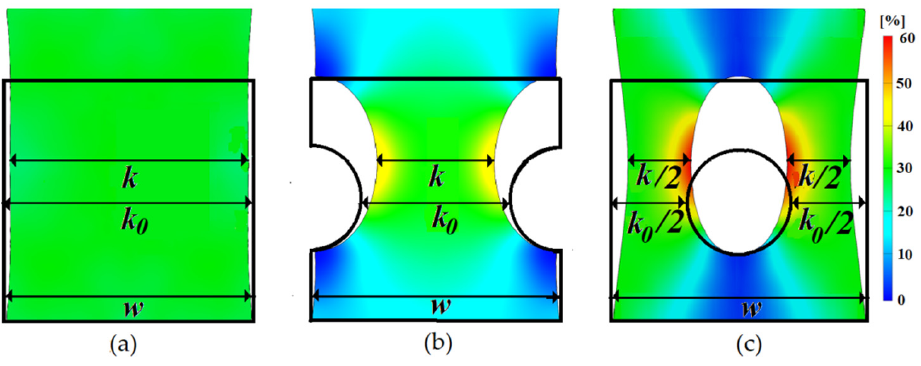
Figure 4. Strain maps ( a ) sample type a, ( b ) sample type b and ( c ) sample type c. For all the analyzed samples, the contraction was observed in the horizontal axis,